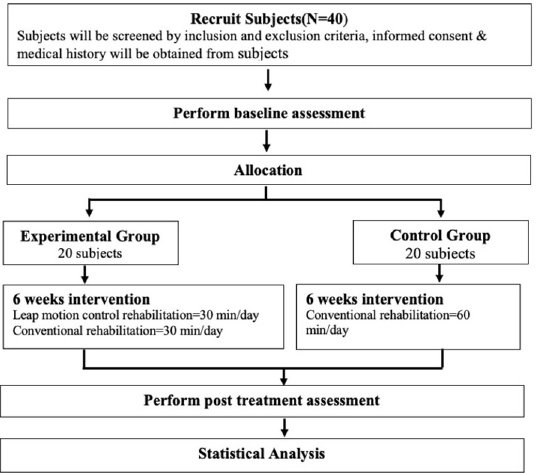
Fig 1. Study flow-chart. Step-wise procedural plan of recruitment, allocation, intervention, and statistical analysis of the study.